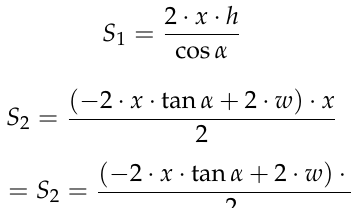
Figure 2. ( a )The design parameters of the channel. ( b ) The height of the channel.